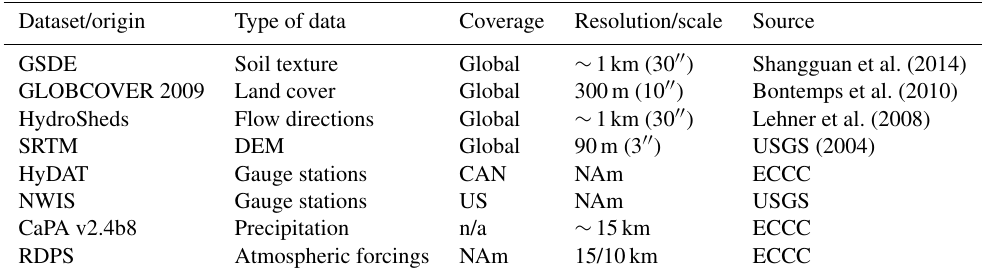
Figure 1. Computation time for GEM-Surf (land-surface part of GEM-Hydro), GEM-Hydro-UH and WATROUTE. See text for details. The number of grid points in this study is 1276 (476000) for GEM-Surf/GEM-Hydro-UH (WATROUTE). Table 1. Data sources. NAm: North America; n/a: not